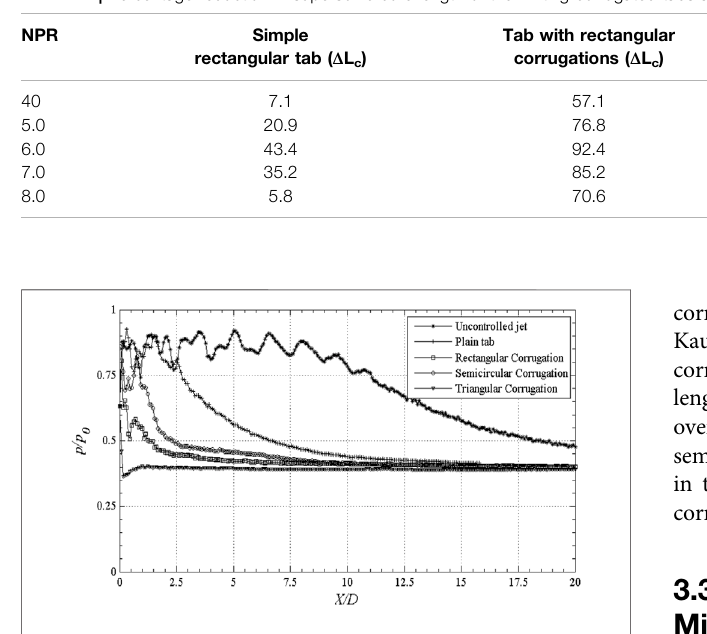
Tab with triangular corrugations ( Δ L c )